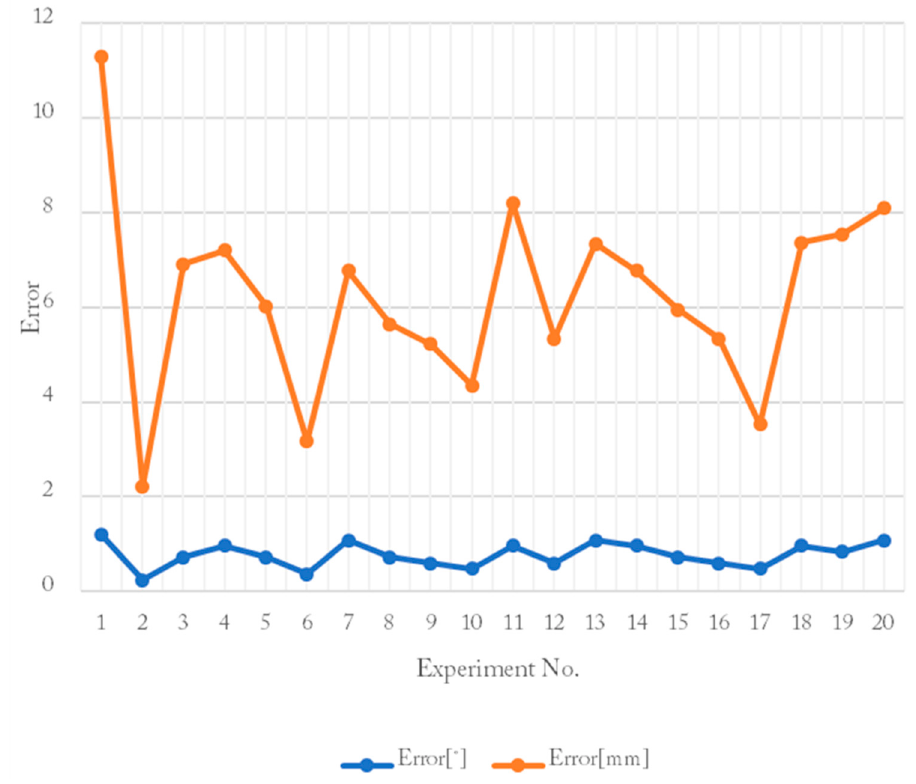
Figure 20. Field experiment results of sweet pepper’s position extraction algorithm (rotation axis).